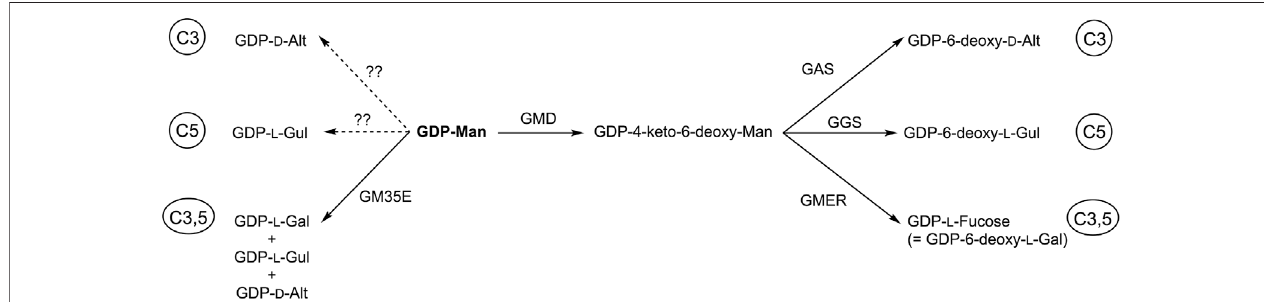
FIGURE 8 | Conversion of GDP-mannose towards GDP-hexose epimers by GDP-mannose 3,5-epimerase (GM35E) or towards GDP-deoxy-hexoses by the consecutive action of GDP-mannose 4,6-dehydratase (GMD) and GDP-6-deoxy- D -altrose synthase (GAS), GDP-6-deoxy- L -gulose synthase (GGS) or GDP-4-keto-6- deoxy- L -mannose 3,5-epimerase-4-reductase (or GDP- L -fucose synthase,